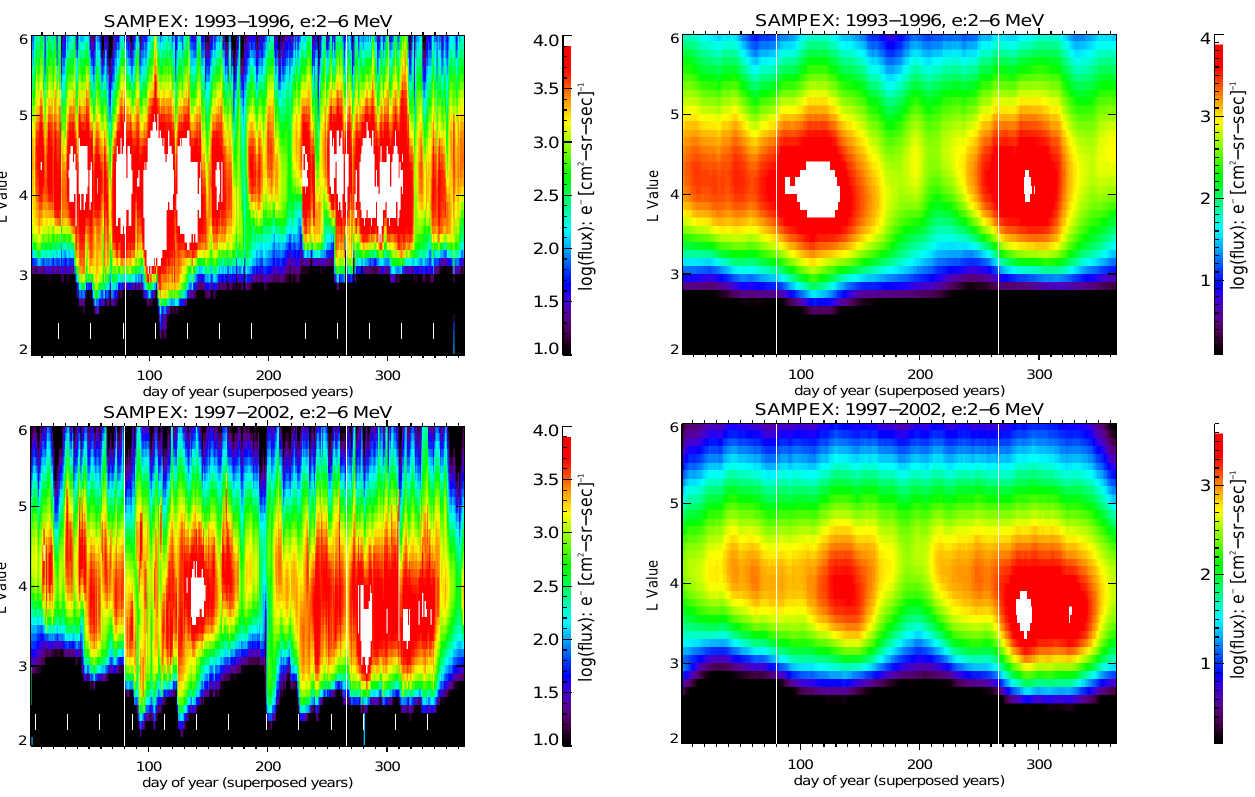
Fig. 2. (a) Annual superposed epoch analysis showing 27-day run- ning box car averaged 2- to 6-MeV electron fluxes (1993–1996) during the descending part of solar cycle 22. (b) Similar to (a) but for the ascending phase of solar cycle 23